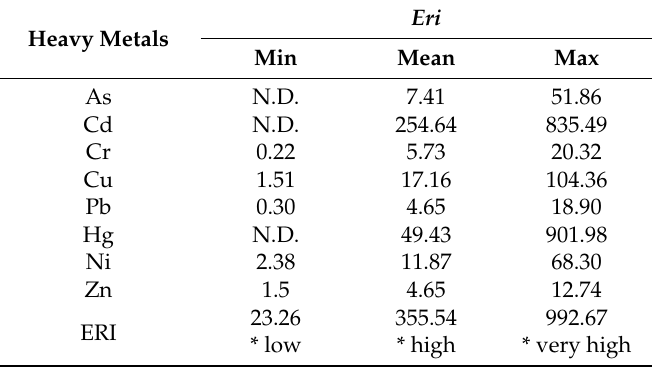
Table 6. Potential ecological risk indices of elements in sediments.